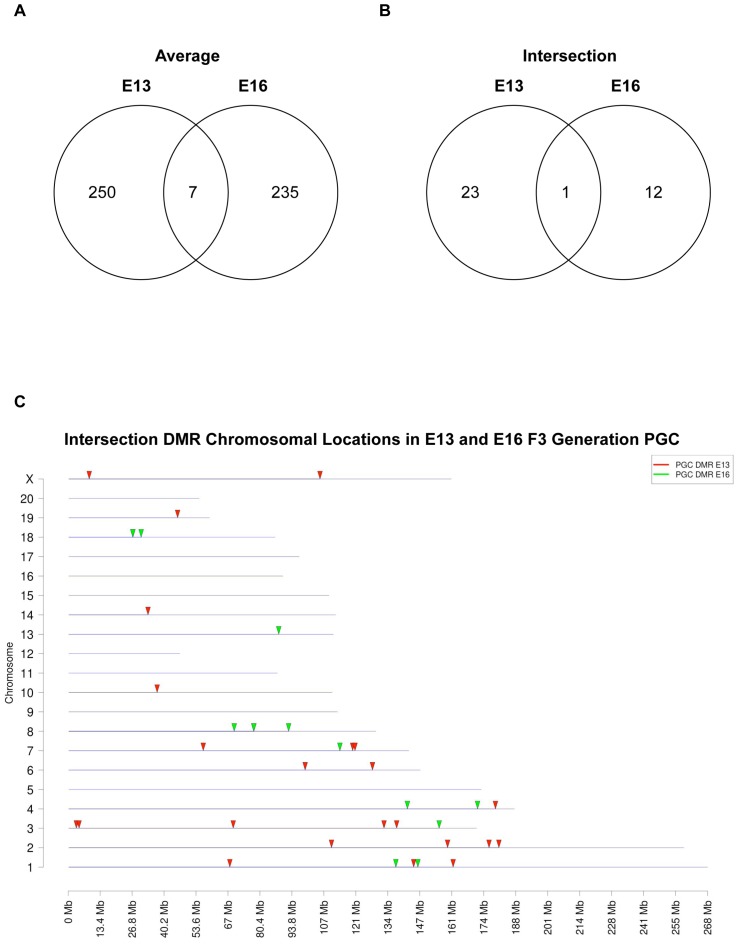
Number of vinclozolin induced transgenerational DMR detected in F3 generation E13 and E16 germ cells, using two different bioinformatic analyses.(A) The analysis is performed by averaging data from three comparative MeDIP-Chip per developmental time using a statistical cut-off of p<10−4. (B) The analysis is performed by selecting only the DMR that repeatedly appeared as significantly changed in all MeDIP-Chip comparisons (intersection) using a cut-off of p<10−4. (C) A graphical representation of the DMR location in all chromosomes in the rat that were obtained through the intersection analysis for both E13 and E16 germ cell DMR.